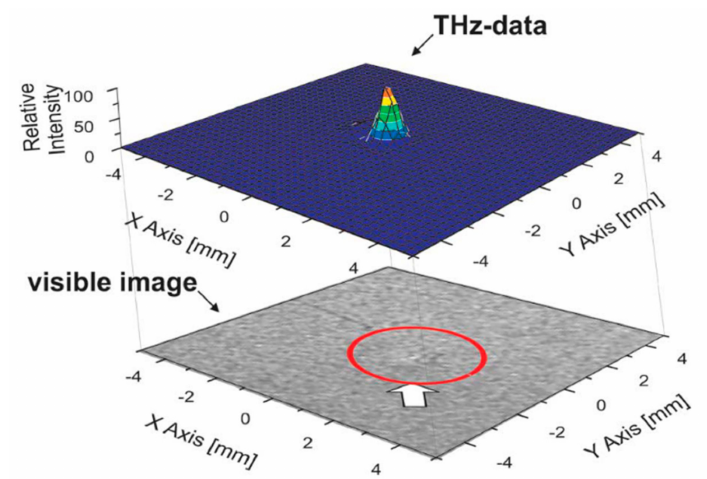
Figure 8. THz dark-field image (top) of a small protrusion on the surface of a steel sheet sample, and the visible image of the same sample (bottom). In the visible image, the protrusion is barely visible (circled in red), whereas it is visible in the THz dark-field image. Reproduced with permission from